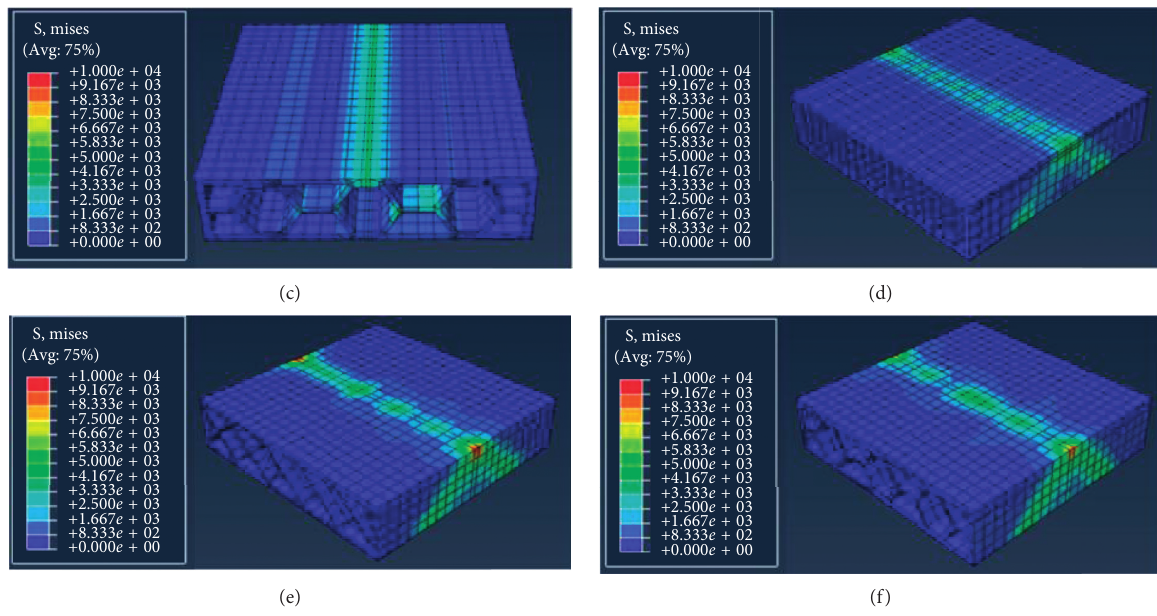
Figure 8: The stress components at integration points of three kinds of samples: (a) vertical supporting structure in perpendicular direction, (b) oblique square grid supporting structure in perpendicular direction, (c) honeycomb grid supporting structure in perpendicular di- rection, (d) vertical supporting structure in parallel direction, (e) oblique square grid supporting structure in parallel direction, and (f) honeycomb grid supporting structure in parallel